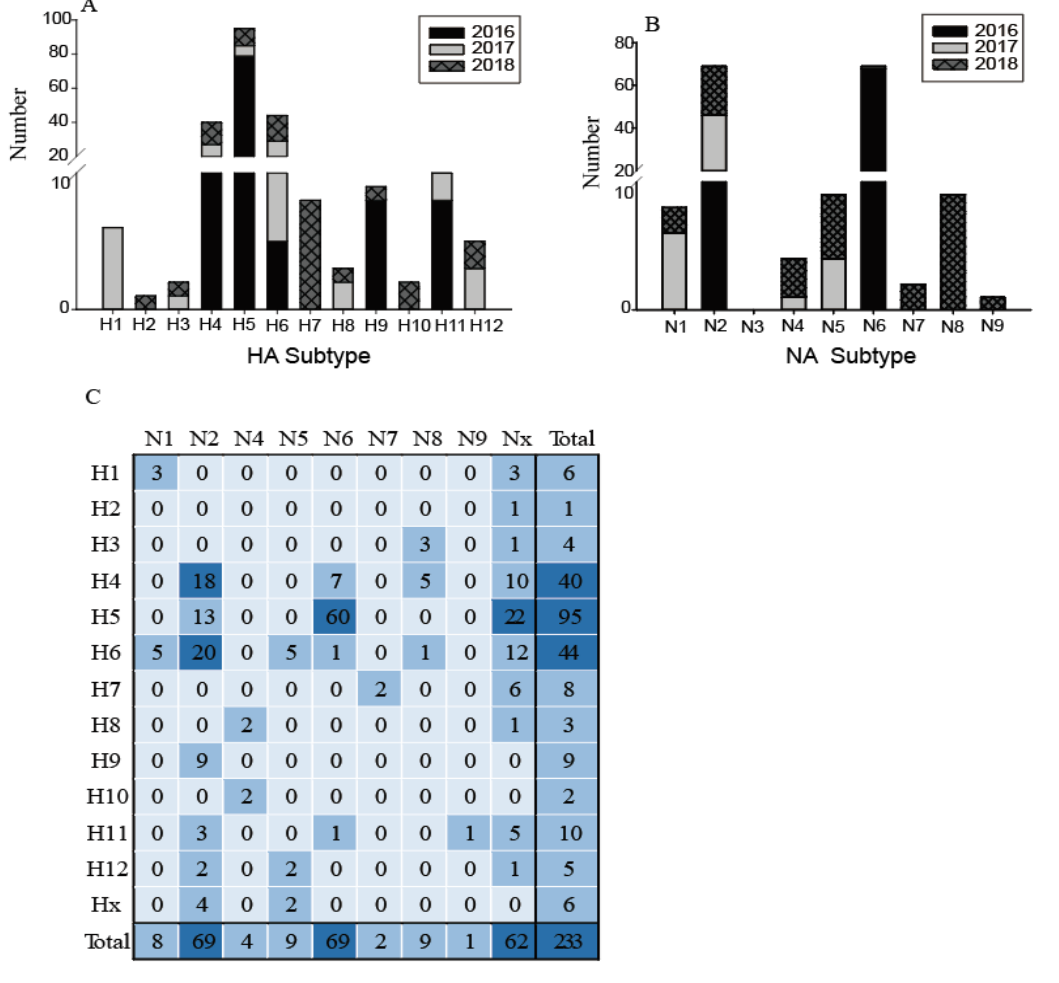
Figure 3. Distribution of haemagglutinin (HA) subtypes, neuraminidase (NA) subtypes and HA/NA subtype combinations during influenza A virus surveillance in wild birds in Shanghai, 2016–2018. ( A ) Number of HA subtypes; ( B ) number of NA subtypes; ( C ). Number of HA/NA subtype combinations. HA/NA subtype combinations (blue) were colored according to the frequencies of detection.